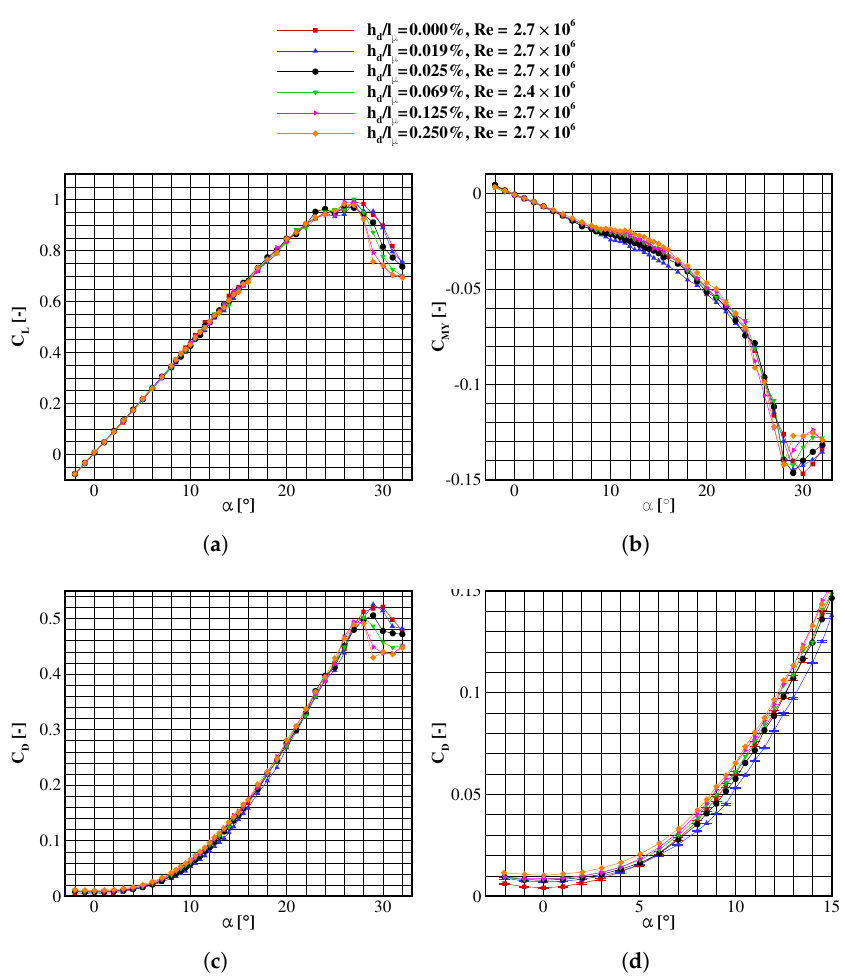
Figure 9. Aerodynamic coefficients of the longitudinal motion as function of angle of attack and roughness height. ( a ) Lift coefficient; ( b ) Pitching-moment coefficient; ( c ) Drag coefficient; ( d ) Detail view of drag coefficient with error